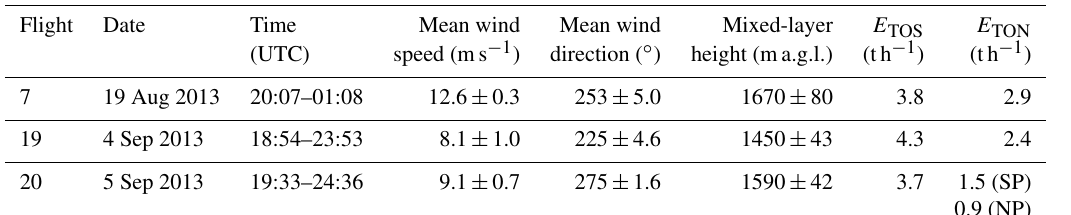
Table 2. Model average meteorological conditions and facility emission rates of TOS ( E TOS ) and TON ( E TON ) during the F7, F19 and F20 flights as described above. SP: southern plume; NP: northern plume.